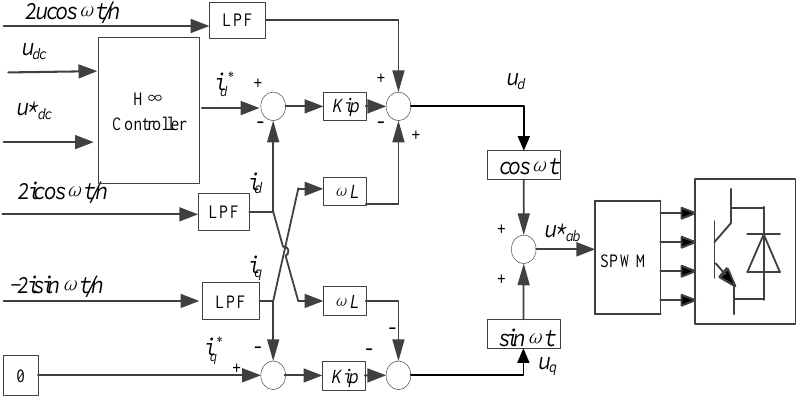
Figure 5. Block diagram of the H∞ controller .